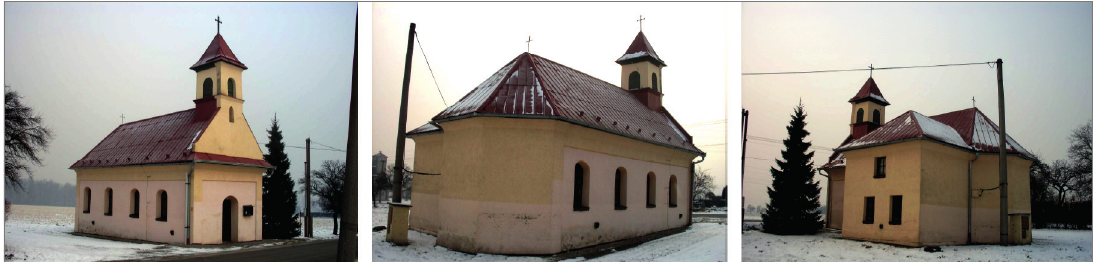
Fig. 5. Demonstration of photographs of the Saint Hedwig Chapel